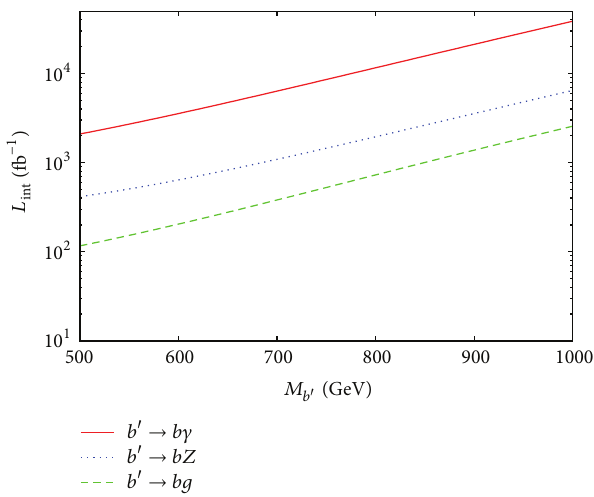
Figure 14: The same as Figure 13, but for parametrization PII.